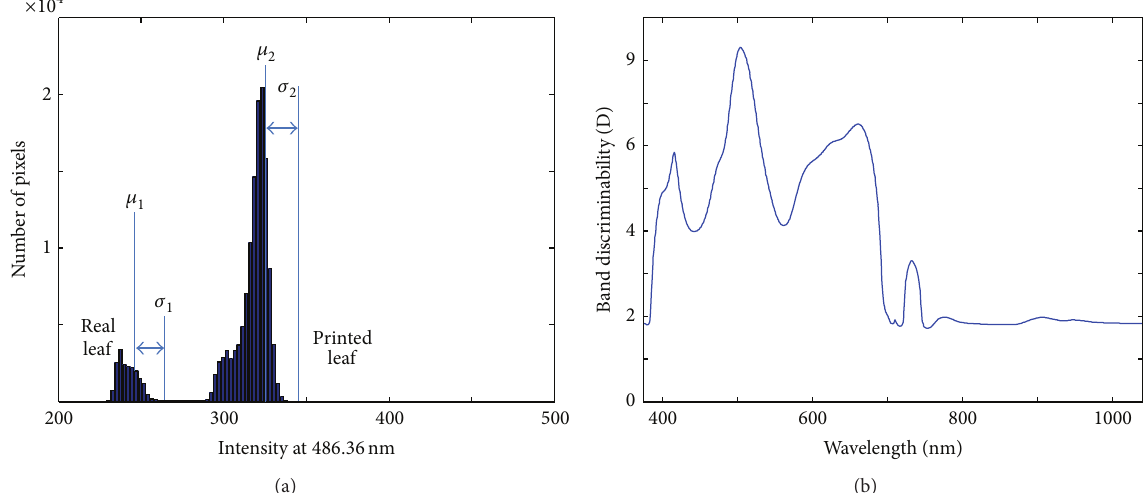
Figure 4: Spectral analysis: (a) test hypercube, (b) band image at 486.36 nm, (c) pixel distribution, and (d) proposed band discriminability graph.